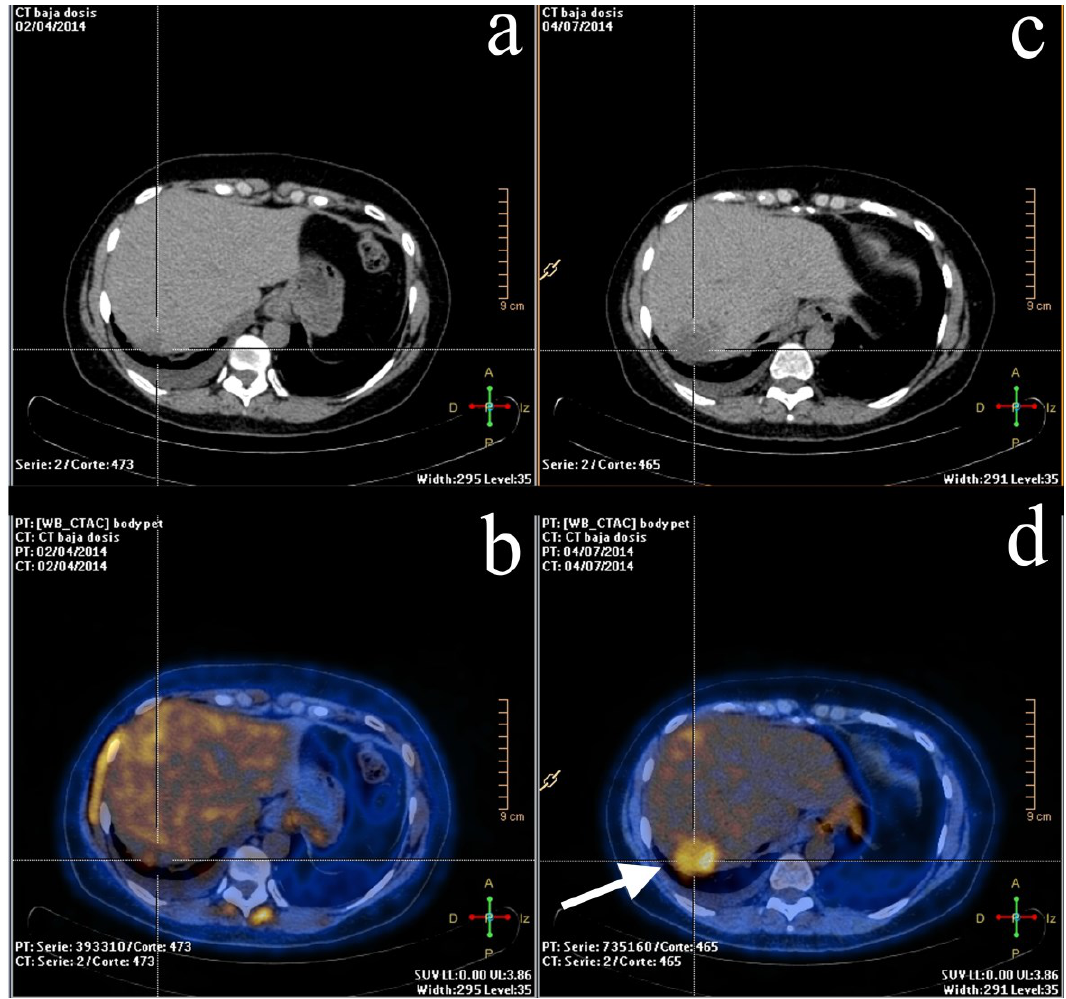
Figure 2. A 53-year-old woman with breast cancer in the course of therapy but with rising biomarkers. The patient was referred for FDG-PET/CT evaluation. Left column : baseline PET/CT scan. ( a ) Non-enhanced CT showing a hypodense lesion in the right posterior hepatic lobe; ( b ) PET/CT. Mild metabolism was shown in the lesion, similar to what was found in the background. Right column : mid-therapy PET/CT scan. ( c ) Non-enhanced CT showing the same lesion but significantly larger than baseline exam. ( d ) Hypermetabolic lesion with heterogeneous distribution of the radiotracer (arrow) shown on PET/CT, consistent with metastatic liver